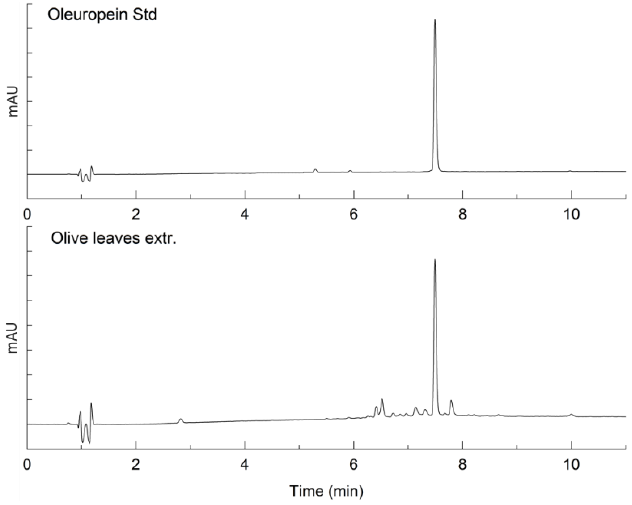
Figure 1. Stacked UV chromatogram of the oleuropein standard and the olive leaf extract.